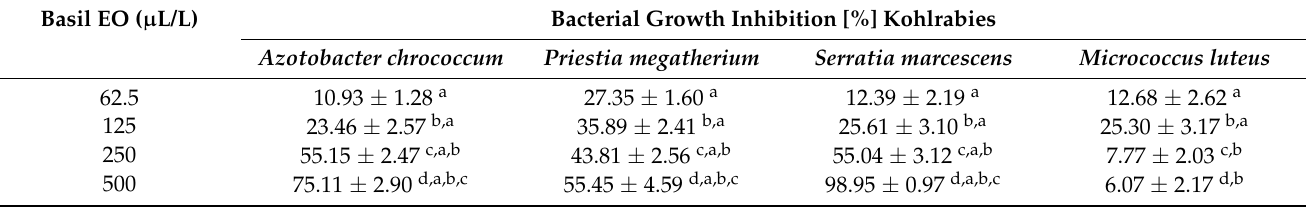
Table 10. In situ analysis of the antibacterial activity of the vapor phase of OBEO on kohlrabies. Basil EO ( µ L/L)